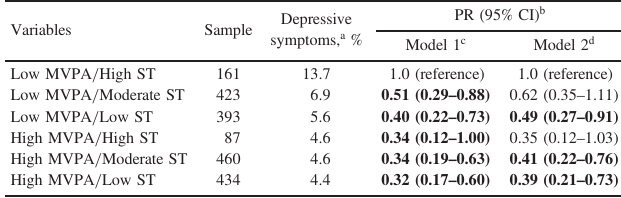
Table 3. Joint associations of moderate-to-vigorous physical activity and sedentary time with depressive symptoms: sensitivity